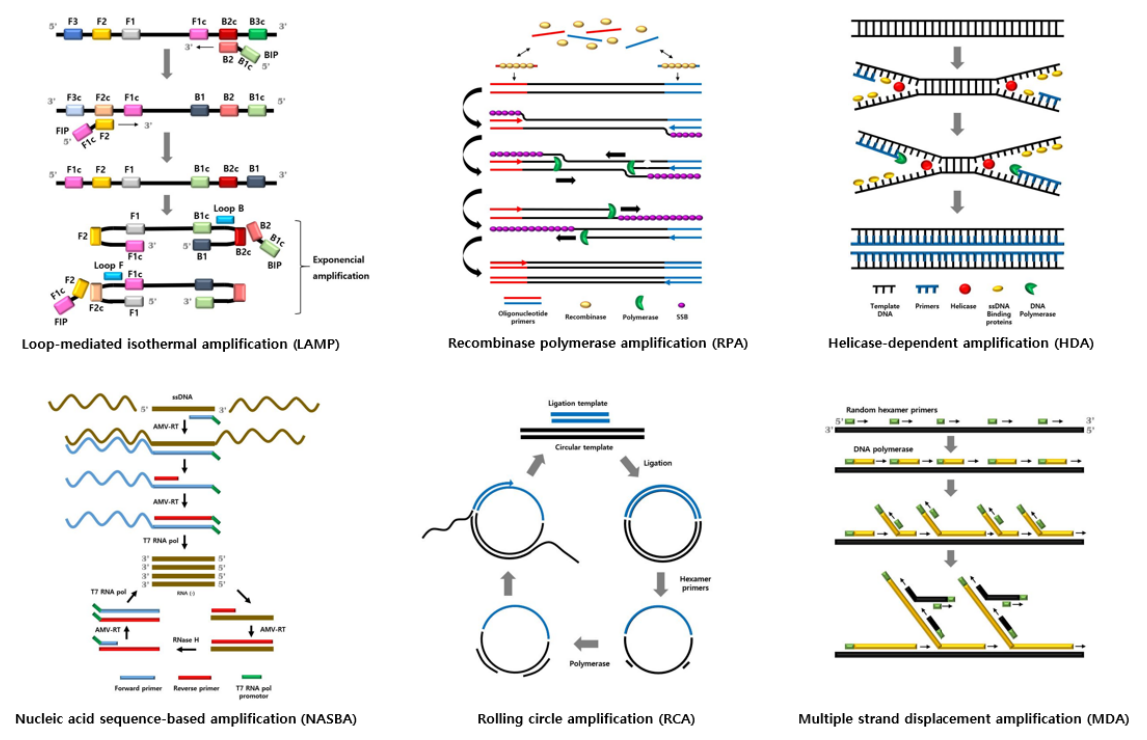
Figure 1. Schematic diagram of isothermal amplification techniques. Table 1. Summary of comparison among various isothermal amplification methods.